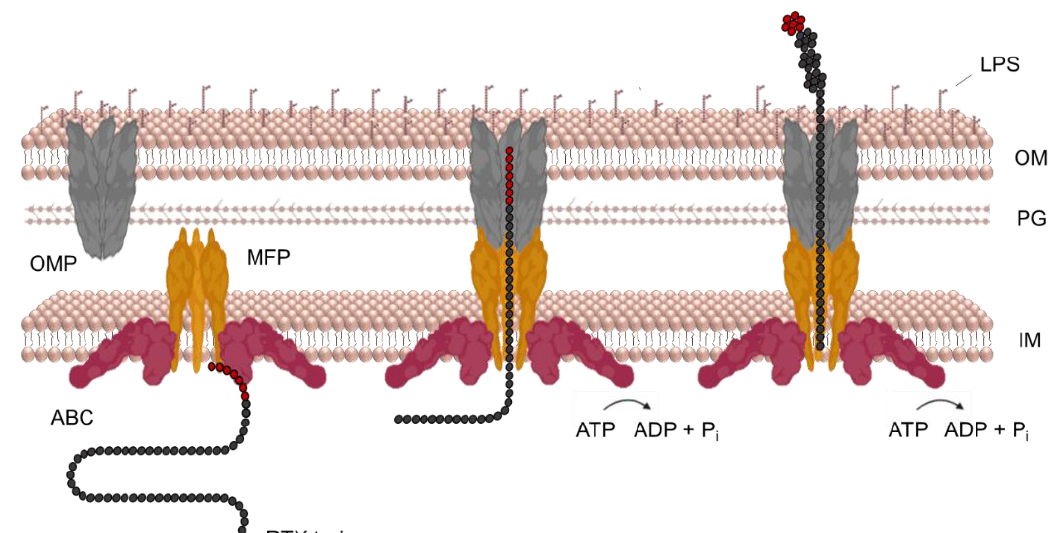
Figure 6. Schematic representation of the T1SS assembly process. Recognition of a C-terminal secretion signal of RTX toxin by the proteins ABC and MFP is followed by recruitment of the trimeric TolC complex and formation of the transport channel. The secretion channel spans both membranes of the Gram-negative bacterium and secretes the toxin from the cytosol into the extracellular environment in a one-step mechanism. The energy for secretion is provided by ATP hydrolysis. ABC, ATP-binding cassette transporter; MFP, membrane fusion protein; OMP, outer membrane protein; LPS, lipopolysaccharide; OM, outer membrane; IM, inner membrane; PG, peptidoglycan. This image was created using BioRender.com (accessed date: 24 February 2022).